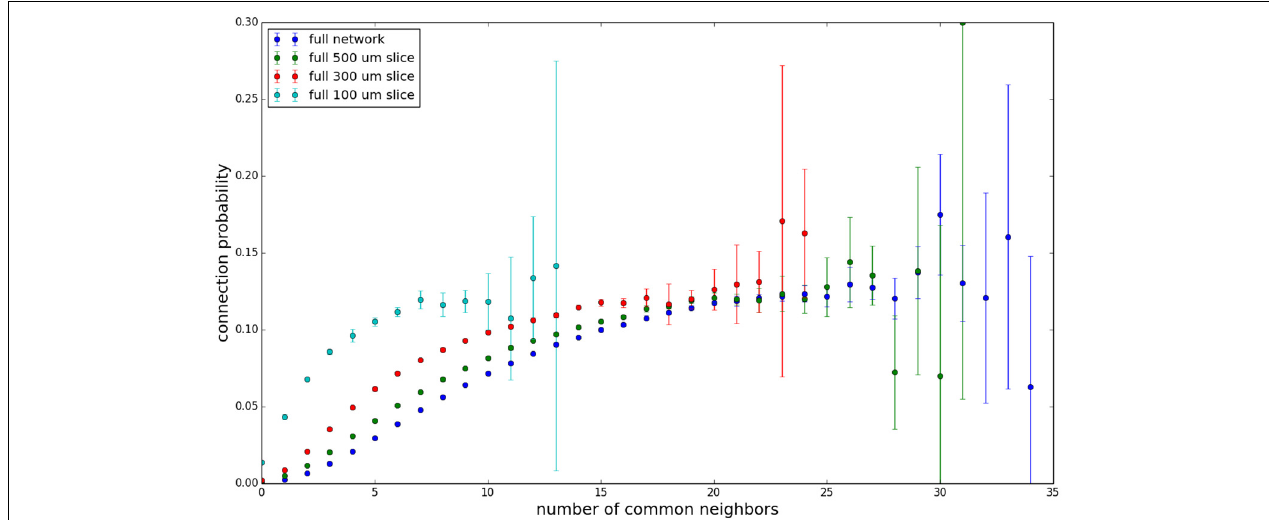
FIGURE 3 | Common neighbor clustering for complete network and slices (full sampling): pairwise connection probability as a function of number of commonly connected neighbors. Error bars indicate standard error of the mean. Average over five populations.